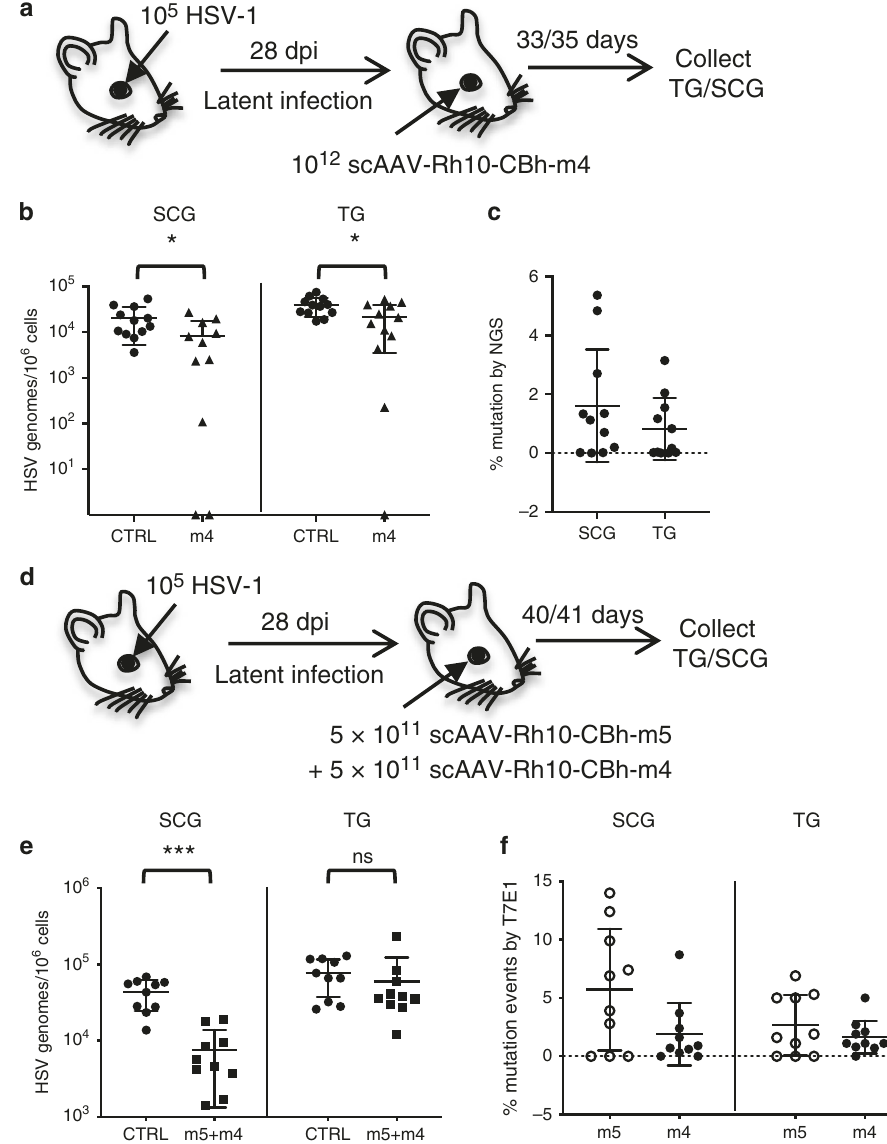
Fig. 3 Reduction of ganglionic HSV genomes after induction of multiple DSB. a Mice latently infected with 10 5 PFU HSV-1 17 + for 28 days, were either left untreated (Controls, CTRL, n = 12) or administered 1 × 10 12 vgs scAAV-Rh10-CBh-m4 (m4, n = 12) by RO injection. These mice were infected and treated at the same time as the mice described in Fig. 2d – f (control mice are the same for these 2 data sets). At 33 – 35 days post meganuclease-therapy, SCGs and right (ipsilateral) TG were harvested and b HSV genomes quanti fi ed by ddPCR. p = 0.03 and p = 0.02 for SCG and TG, respectively. c NGS analysis of SCG and TG from dual-meganuclease-treated mice to detect HSV gene editing at the m4 target site in SCG or TG. d Mice latently infected with 10 5 PFU HSV-1 17 + for 28 days were either left untreated (Controls, CTRL, n = 10) or administered 5 × 10 11 vgs scAAV-Rh10-CBh-m5 + 5 × 10 11 vgs scAAV-Rh10-CBh-m4 (m5 + m4, n = 10) by RO injection. At 40 – 41 days post meganuclease-therapy, SCGs and right (ipsilateral) TG were harvested from infected mice either untreated (closed circles) or treated with m5 + m4 (closed squares) and e HSV genomes quanti fi ed by ddPCR, p = 0.00001 for SCG. f NGS analysis of SCG and TG from dual-meganuclease-treated mice to detect HSV gene editing at m5 (open circles) and m4 (closed circles) target sites in SCG or TG. ns: not signi fi cantly different from controls, * p < 0.05, ** p < 0.01, *** p < 0.001, signi fi cantly different from controls. All data are presented as mean values ± SD. Statistical analysis was conducted using unpaired multiple t -tests without correction for multiple comparison. Source data are provided as a Source data fi